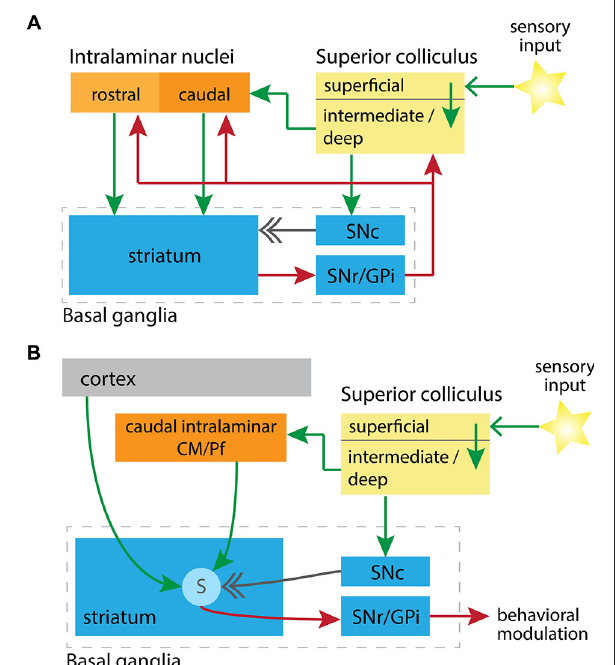
FIGURE 1 | Circuit diagrams illustrating (A) the synaptic relationships between key subcortical nuclei, and (B) the convergence in the striatum of learning signals from these nuclei. In both diagrams excitatory projections are green, inhibitory are red, and the neuromodulatory dopaminergic projection is in gray. (A) Putative subcortical loops are formed between the SC, rostral or caudal intralaminar nuclei, and through the basal ganglia to return to the SC. SNc, substantia nigra pars compacta; SNr/GPi, substantia nigra pars reticulata and globus pallidus internal segment. (B) Convergence onto striatal spiny projection neurons (labeled “S”) of a short-latency sensory signal from the SC, and a related short-latency dopaminergic signal from the SNc. When this conjunction is aligned with cortical input to spiny neurons, representing motor efferent copy, then the factors previously identified as necessary for potentiation of corticostriatal synapses are present (Reynolds and Wickens, 2002). CM/Pf, center median and parafascicular